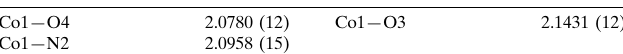
Selected bond lengths (A˚ ).